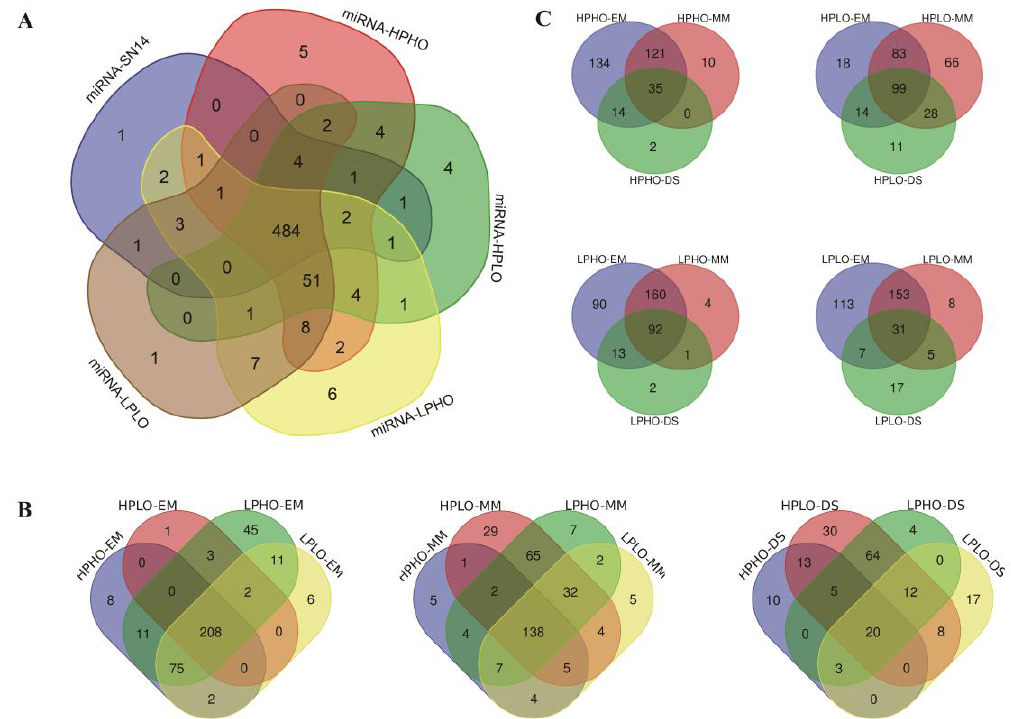
Figure 2. Venn diagram that specifically expressed MicroRNA (miRNA ) in four lines (HPHO, HPLO, LPHO, LPLO) at the EM, MM, DS stage. ( A ) Expression of miRNAs in various materials. ( B ) Di ff erential expression of known miRNA at EM, MM, DS stage ( C ) Di ff erential expression of known miRNA for each extreme material.